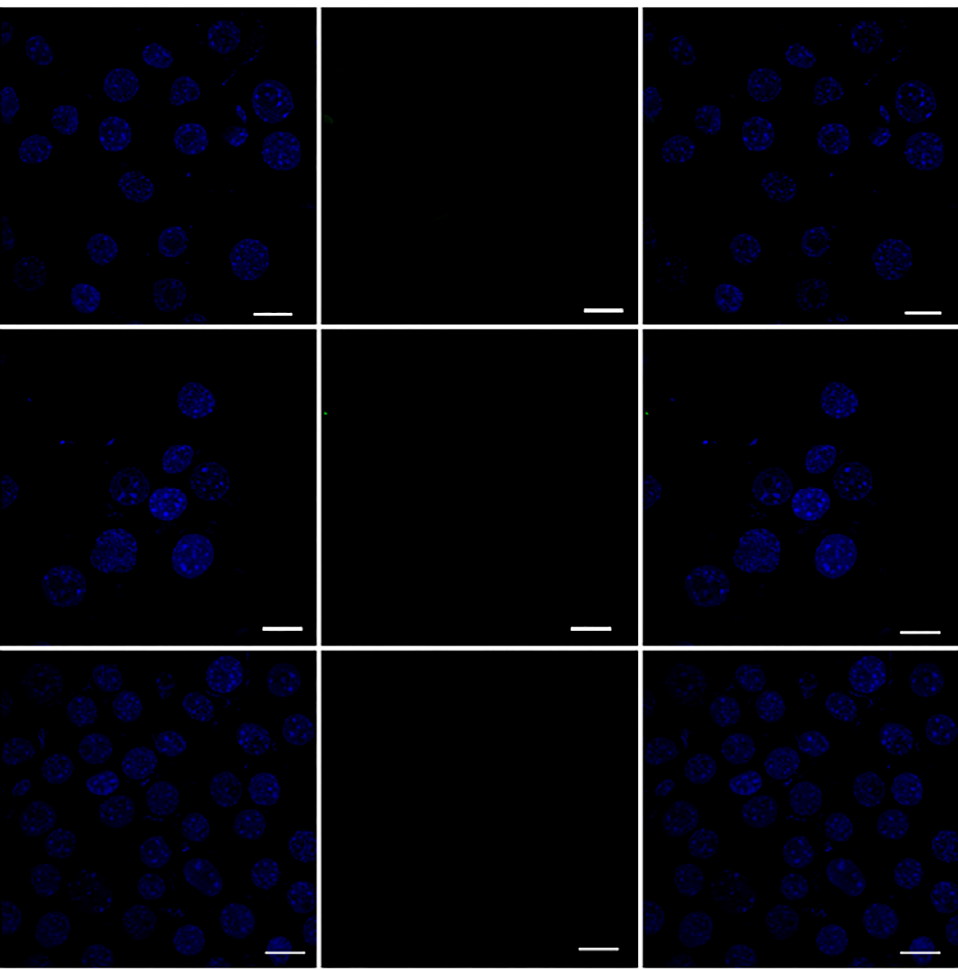
Figure 10. CLSM image of RAW 264.7 macrophage cells incubated with FITC alone. For each panel, the images from left to right show cell nuclei stained by DAPI (blue), the fluorescence of the FITC (Green) and overlays of the two images. Scale bar = 10 µm.